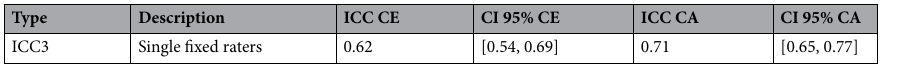
Table 1. Results ICC for the CE and CA for untrained